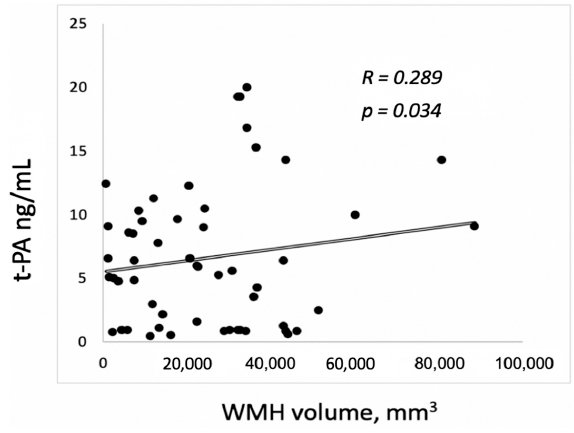
Figure 2. The relationship between t-PA level and WMH volume.